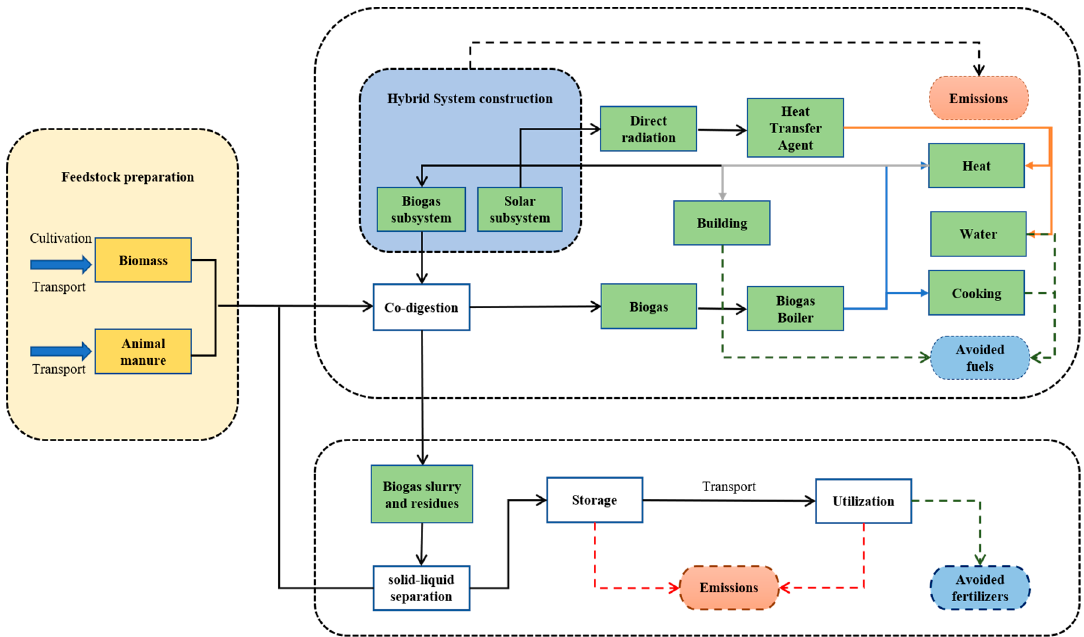
Figure 2. System boundary.